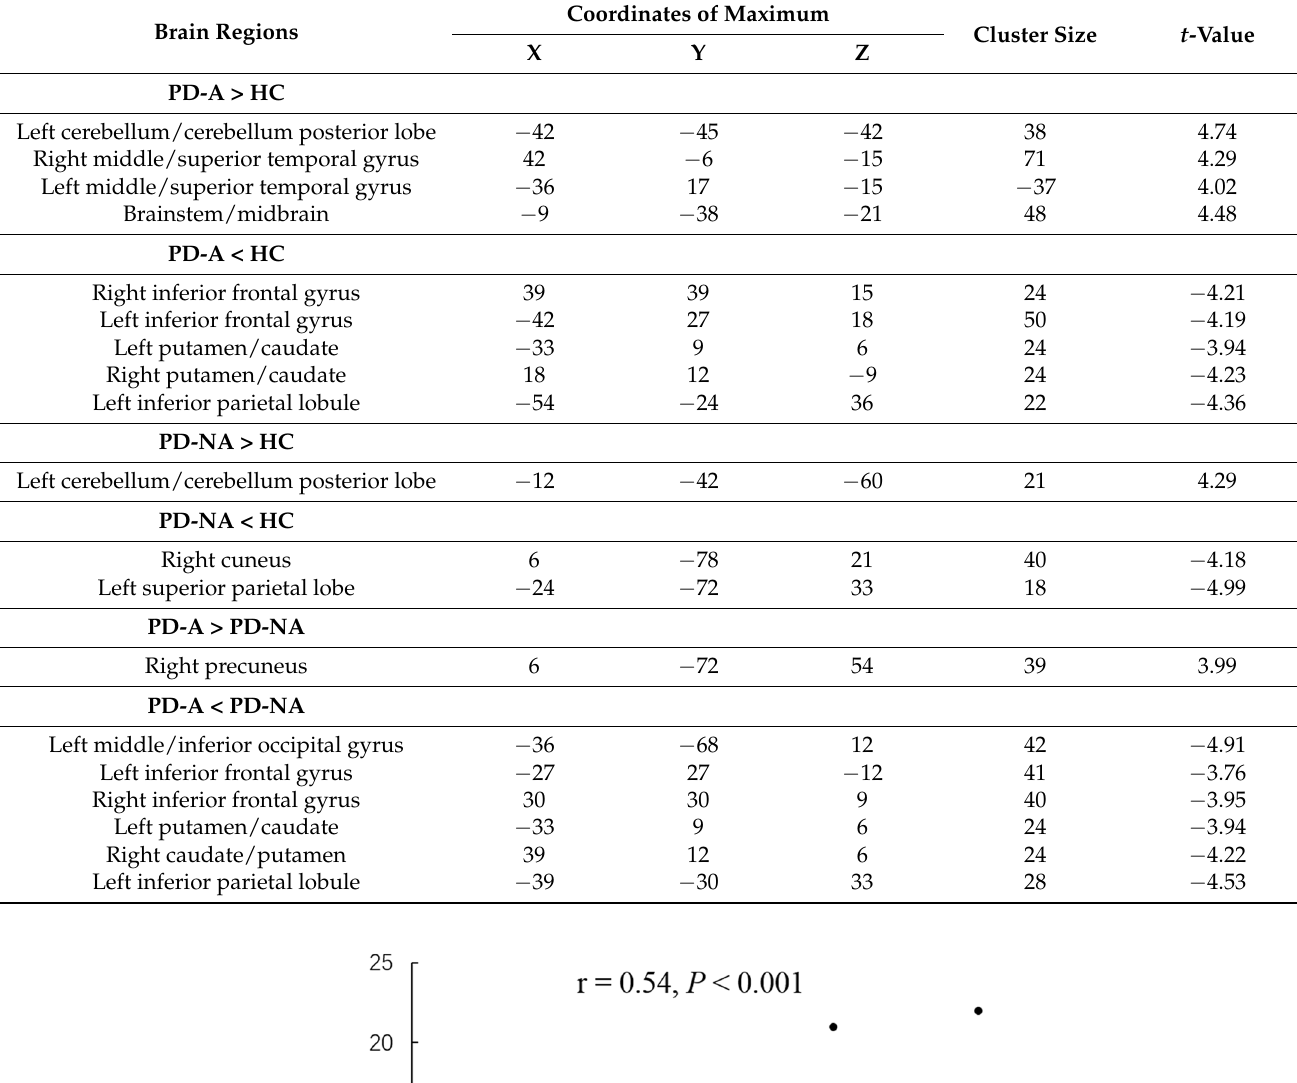
Table 3. Brain regions with significant between-group DC differences.